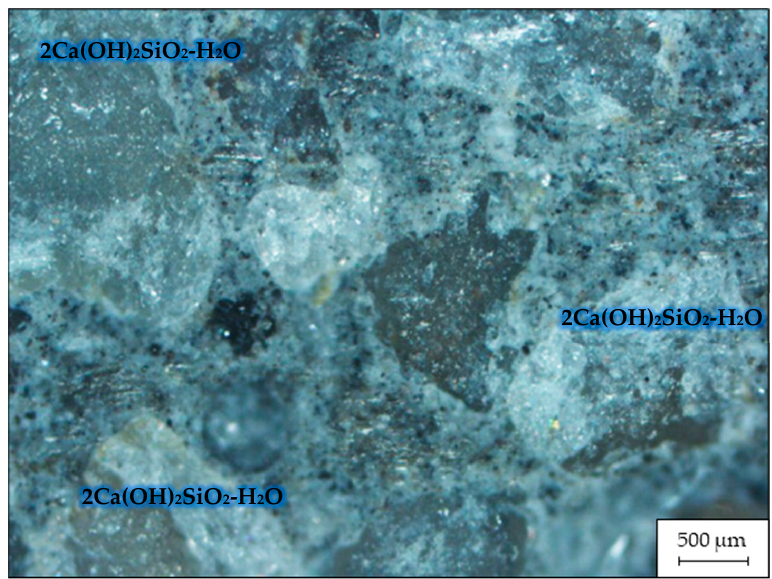
Figure 5. Microstructure of a fracture of the RHC with pure cement without any additives.